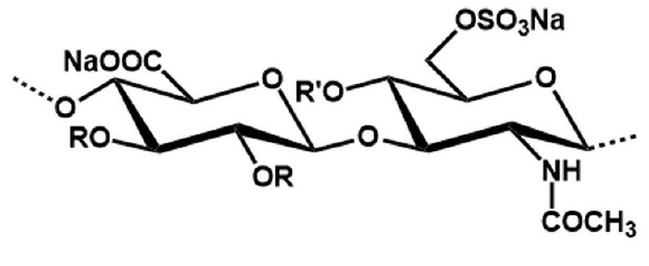
Figure 7. Structural characteristic of sulfated GAG